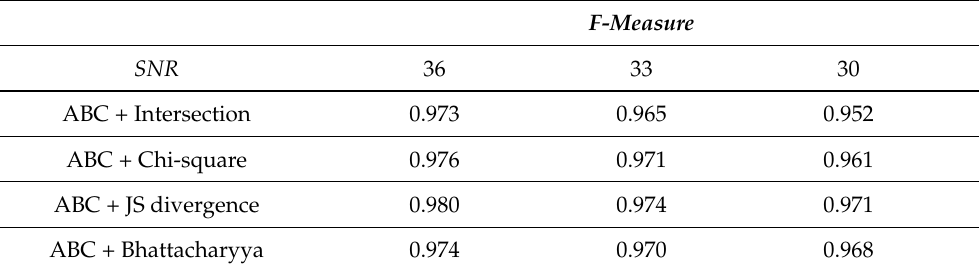
Table 4. Performance of ABC with various similarity measures.